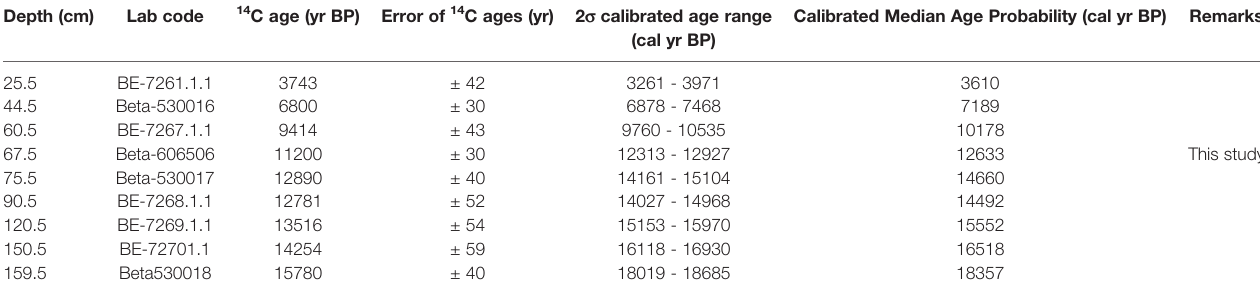
TABLE 1 | Calibrated AMS 14 C ages measured on the planktonic foraminifera Globigerinoides ruber (pink) using the software Calib (version 8.2) and the MARINE20 calibration curve with D R = -81 ± 124. Depth (cm) Lab